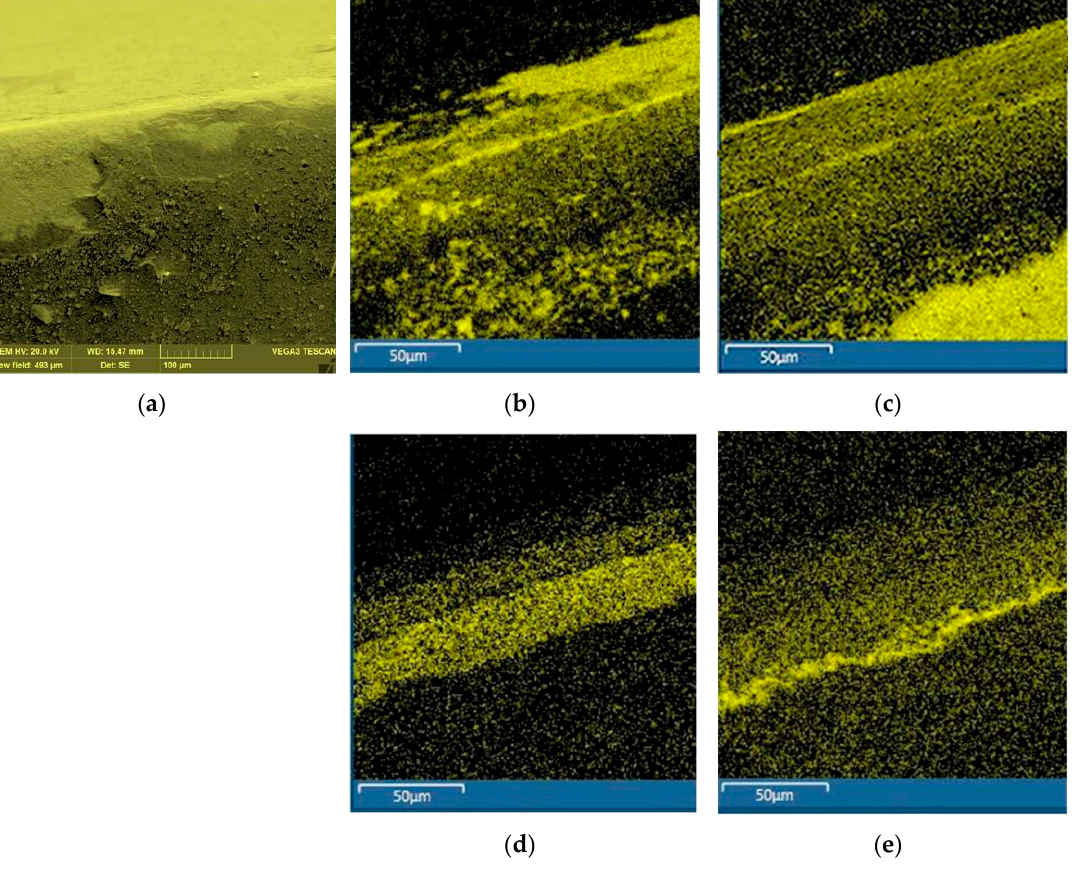
Figure 8. Contrasting SEM images of the distribution of titanium (yellow particles) on the front surface of end mills with different coatings after passing a cutting path of 200 m: ( a ) image of the front surface of the tool; ( b ) uncoated; ( c ) TiN–Al/TiN; ( d ) TiN–AlTiN/SiN; ( e ) CrTiN–AlTiN–AlTiCrN/SiN.